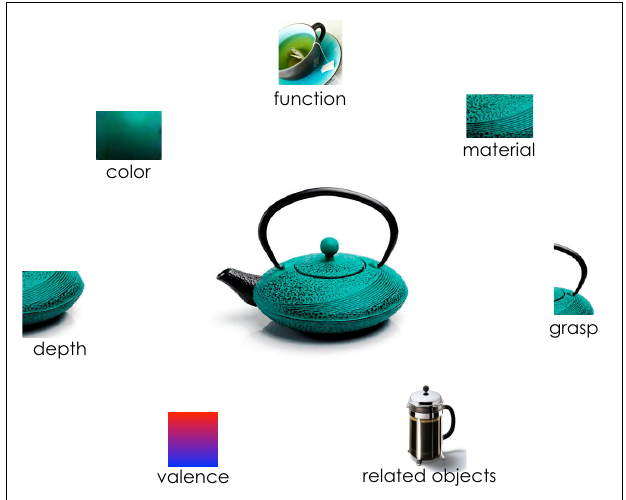
FIGURE 1 |A common, everyday object and variety of high-level object properties that may be components of its mental representation.